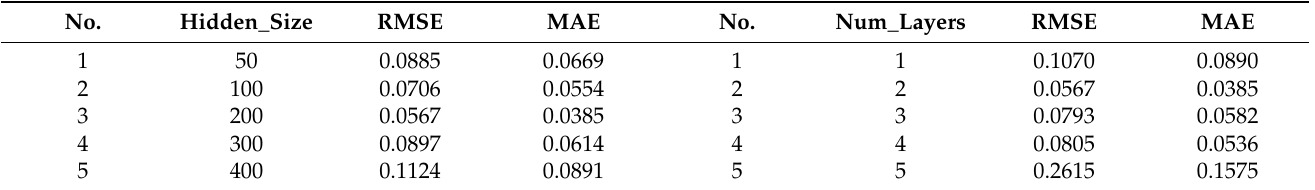
Table 1. Results of the proposed method with different hide layer size and number of LSTM layers.